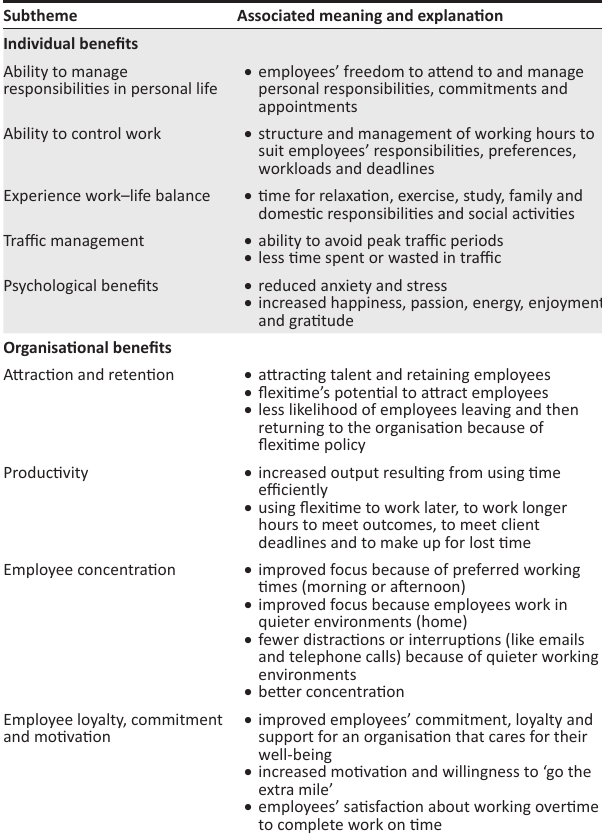
TABLE 4: Benefits that would follow the use of